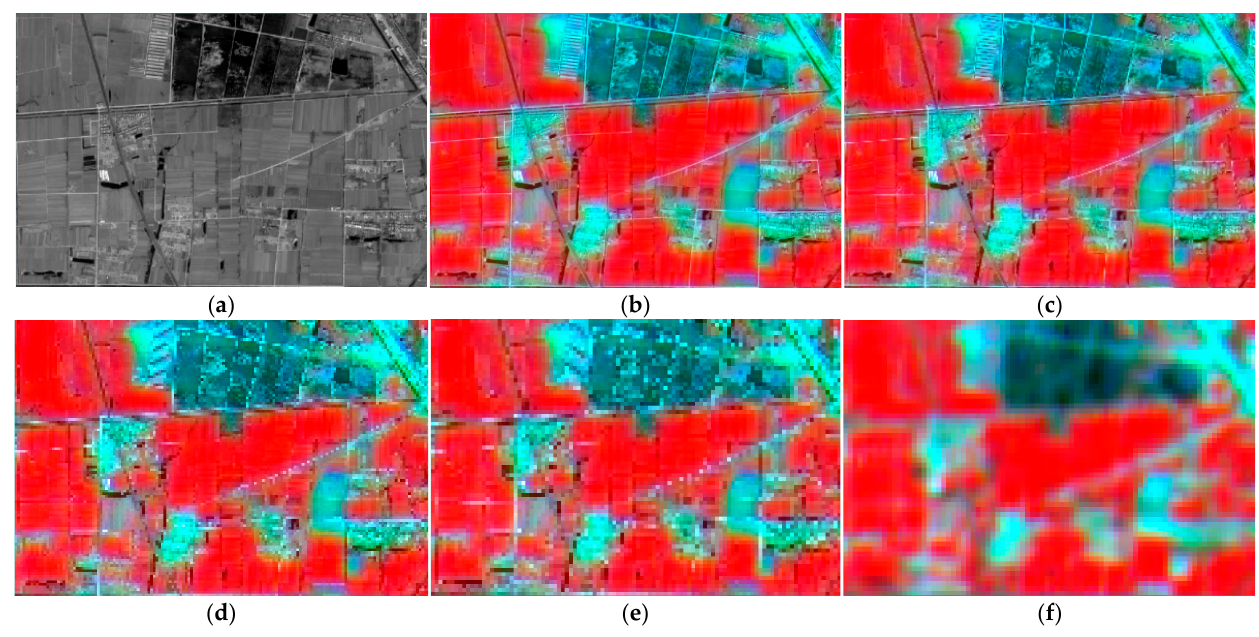
Figure 4. Intuitive comparison between fused images at different scales and original images of local area. ( a ) GF-1/PMS 2 m panchromatic image; ( b ) 2 m × 2 m fused image; ( c ) 8 m × 8 m fused image; ( d ) 16 m × 16 m fused image; ( e ) 24 m × 24 m fused image; ( f ) HJ-1/CCD 30 m multispectral image.